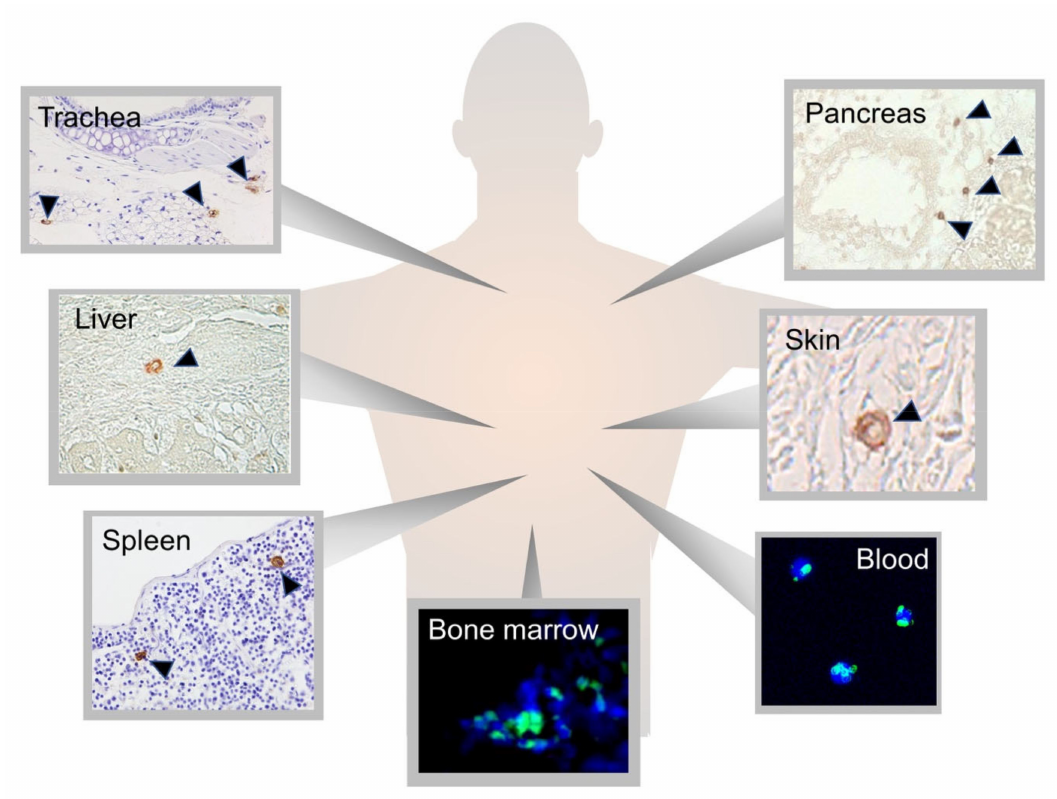
Figure 1. Distribution of Muse cells in the body. Muse cells, detected as SSEA-3(+), distribute in the bone marrow (green signal) [7], peripheral blood (green signal) [4], and connective tissue of various organs, such as the trachea, liver, spleen, pancreas, and skin (brown signal)